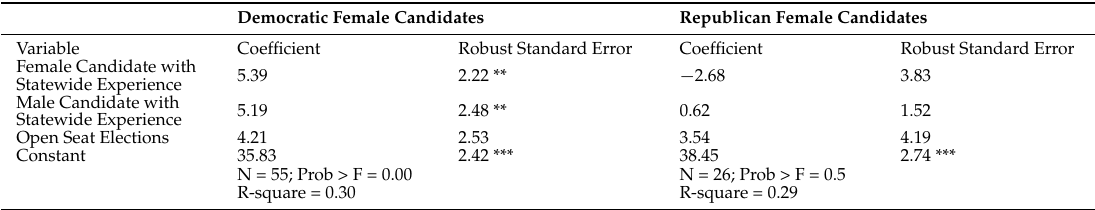
Table 4. Reduced model explaining vote for female gubernatorial candidates running as challengers or in open-seat elections by party,